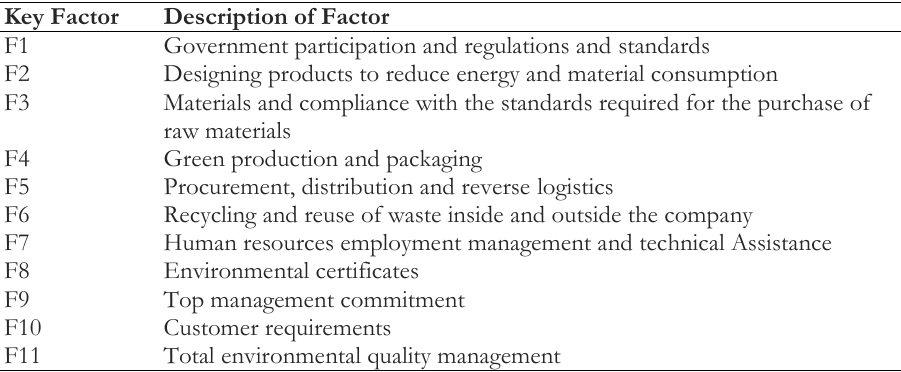
Table 5. Key factors in